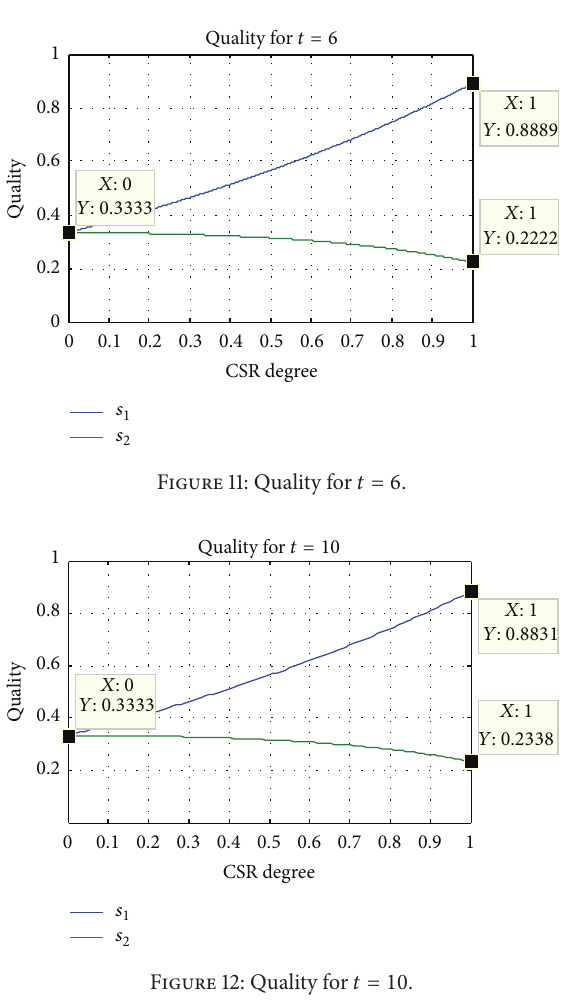
Figure 10: Quality for 𝑡 = 5 .